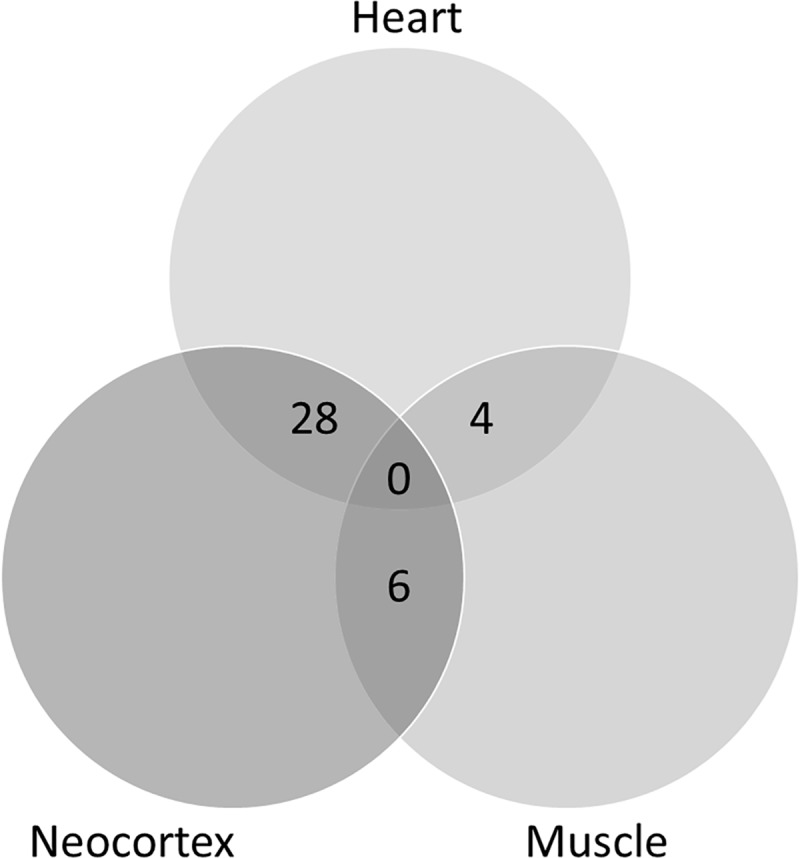
Venn diagram constructed with lists of differentially expressed genes corresponding to the three tissues (neocortex, heart and muscle) as identified using the GEO2R tool.The lists of genes were first curated as indicated in Material and Methods.